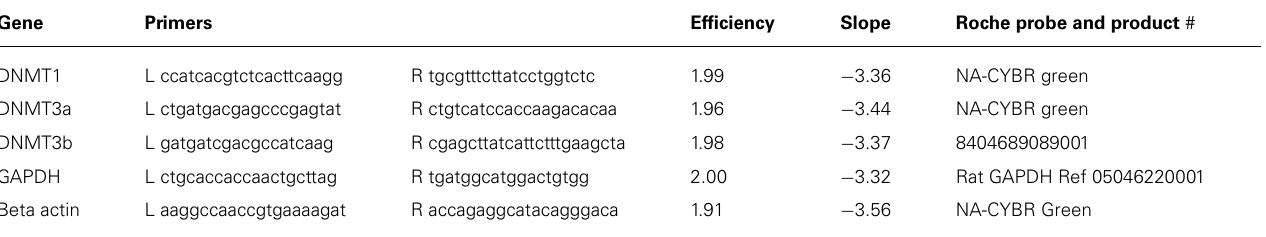
Table 1 | Primer sequences, efficiencies, slopes, and Roche probes used for genes of interest. Gene Primers Efficiency Slope Roche probe and product